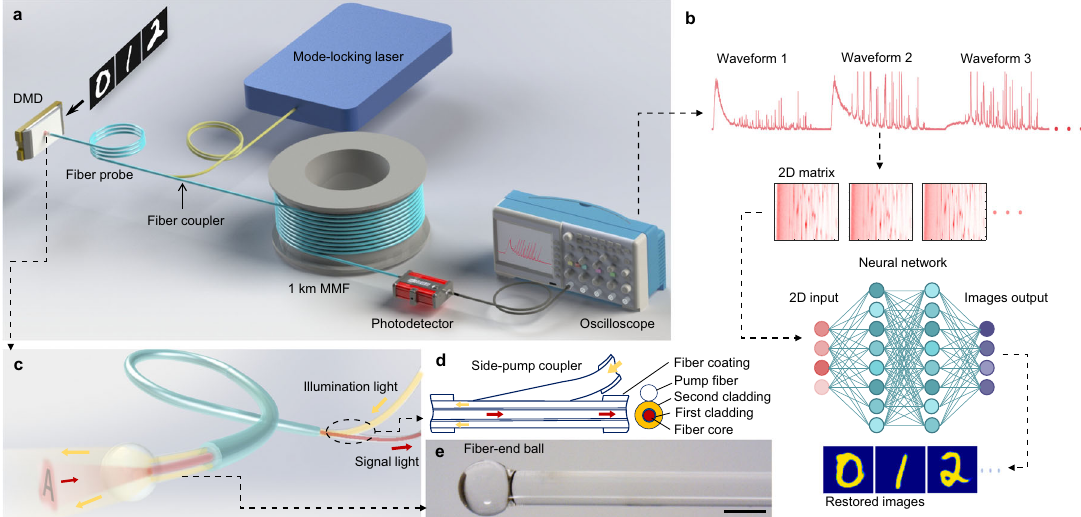
Fig. 2 Experimental layout. a Schematic of the experimental setup. b Flow of the reconstruction process from waveforms to images. c Schematic of the fi ber-end ball, the side-pump fi ber coupler, and the fl ow of illumination light (orange arrows) and signal light (red arrows). d Structures of the side-pump coupler and triple-cladding fi ber probe, where illumination light (orange arrows) is coupled into and transmitted through the cladding of the fi ber, while signal light (red arrows) is collected and transmitted through the fi ber core in the opposite direction. The cross section of this coupling region is also shown. The triple-cladding fi ber consists of the fi ber core (red), fi rst cladding layer (blue), and second cladding layer (orange). e Micrograph of the fi ber-end ball. Scale bar: 500 μ